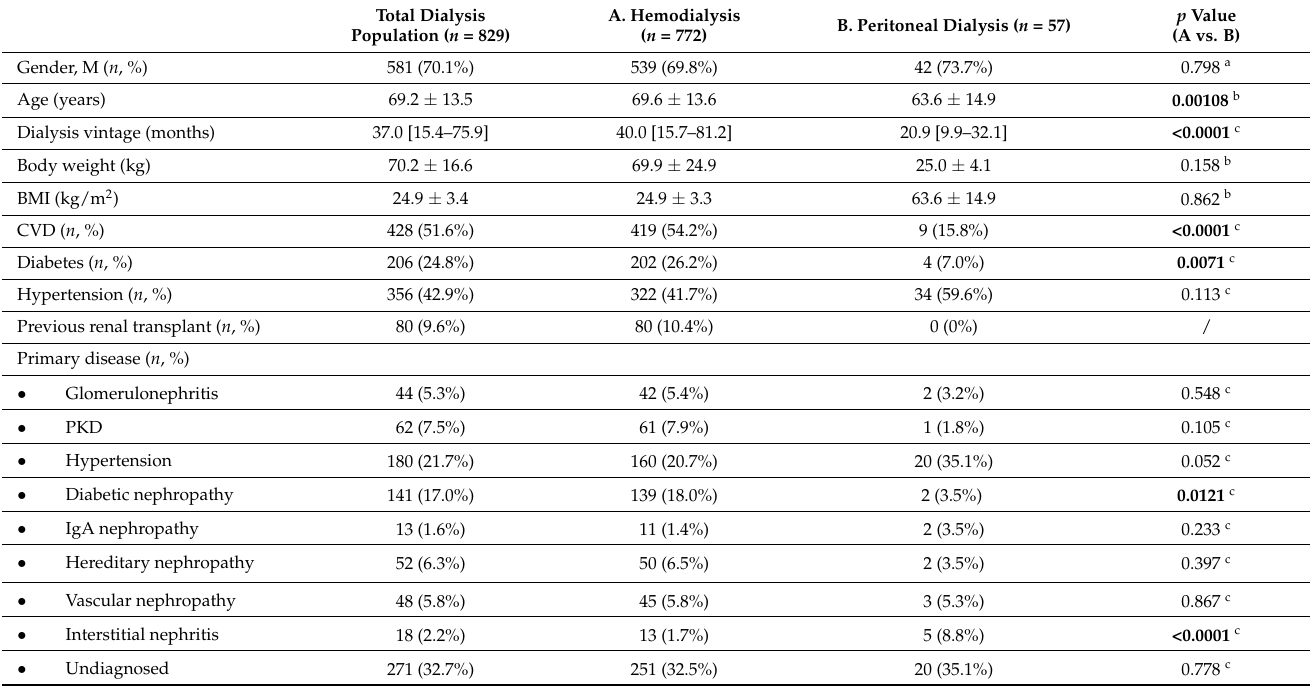
Table 1. Demographic and clinical variables in total hemodialysis and peritoneal dialysis population patients were followed during the 4-mont period (from November 2021 to February 2022) at the Nephrology and Dialysis Units of the local health authority of Romagna (Forl ì -Cesena, Ravenna and Rimini). Continuous variables are presented as means ± standard deviation (SD) in normally dis- tributed and as median with interquartile range (IQR) in square brackets if non-normally distributed, and nominal variables are presented as percentage and absolute numbers in brackets. Significant p -values are in